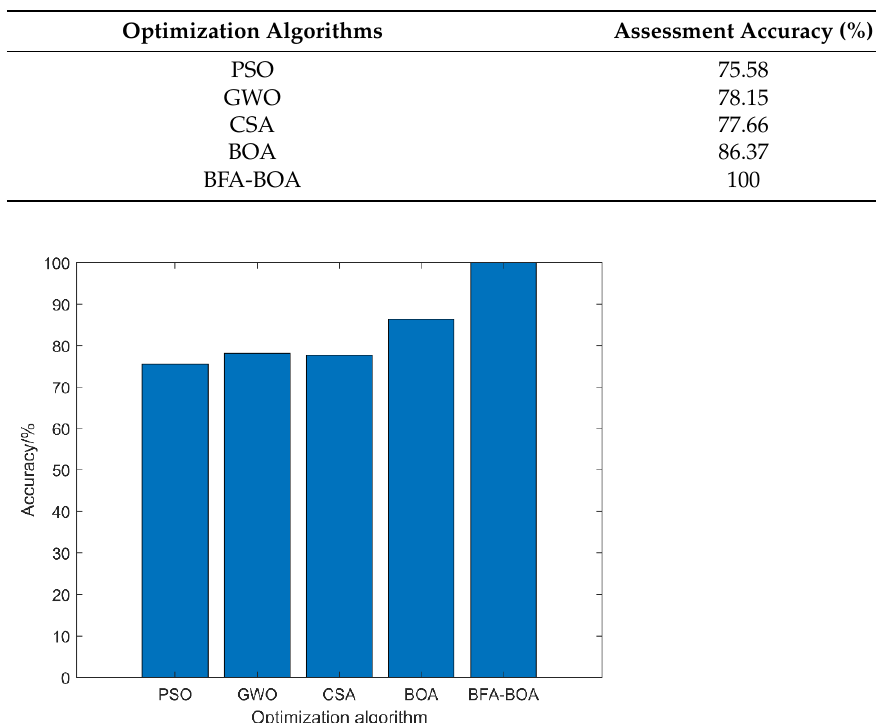
Table 9. Assessment results under different optimization algorithms.